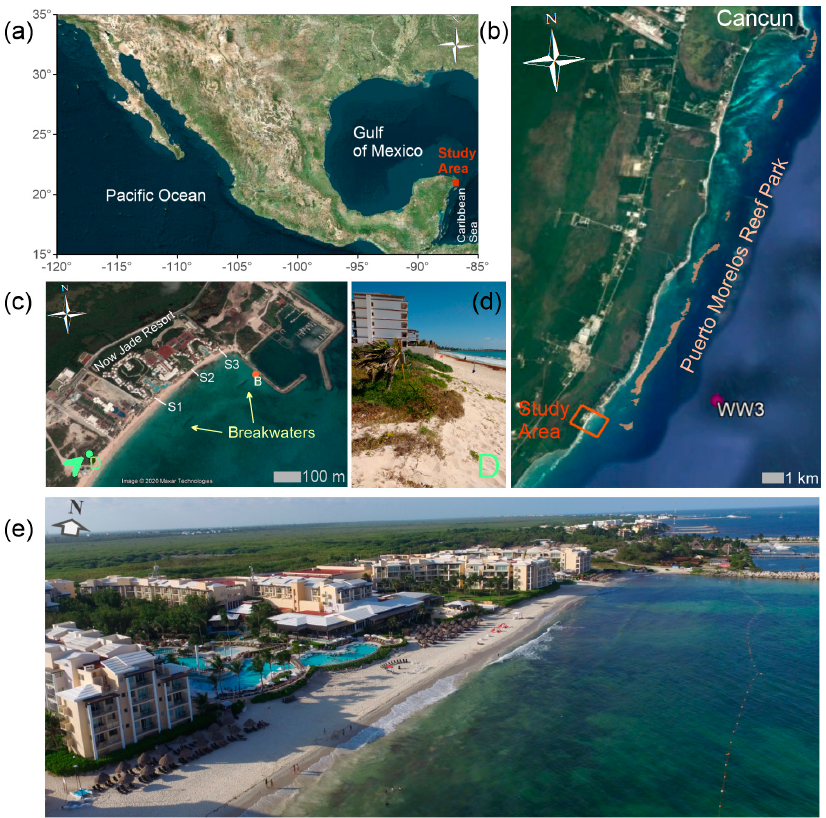
Figure 2. The study area: ( a ) general location; ( b ) Coast at Puerto Morelos; ( c ) aerial view of the Now Jade resort; ( d ) existing dunes, 250 m south of the study area, taken 26 April, 2017; ( e ) aerial view, taken 12 August, 2019.